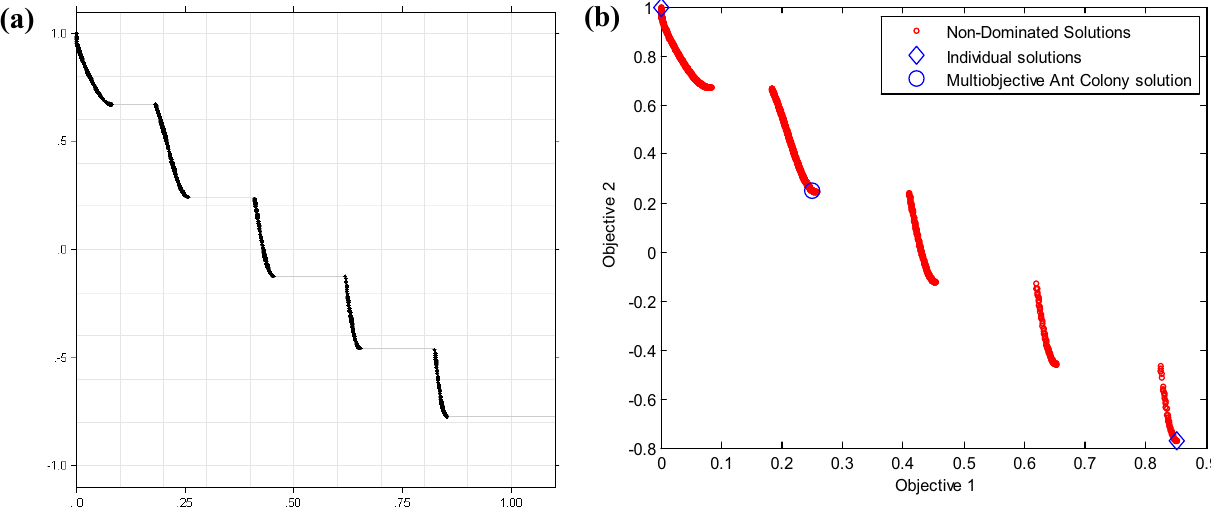
Fig. 5 Pareto front of ZDT3 a standard Pareto front (Deb 2010) and b obtained by multiobjective ant colony optimization Table 5 Computational load comparison between the generation of standard Pareto front and MOACO approach Type of function Computational load in Computational load in terms of CPU time (s) terms of iterations Standard Pareto (Chase et